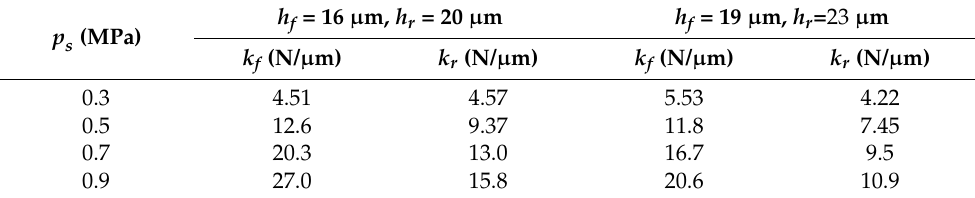
Table 5. Radial stiffness of journal bearings at different supply pressures and radial